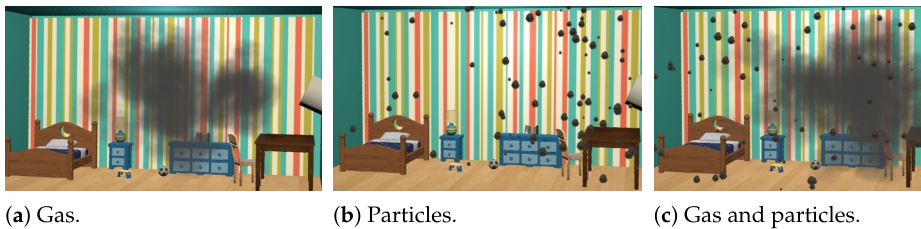
Figure 3. Graphical representation of gases and